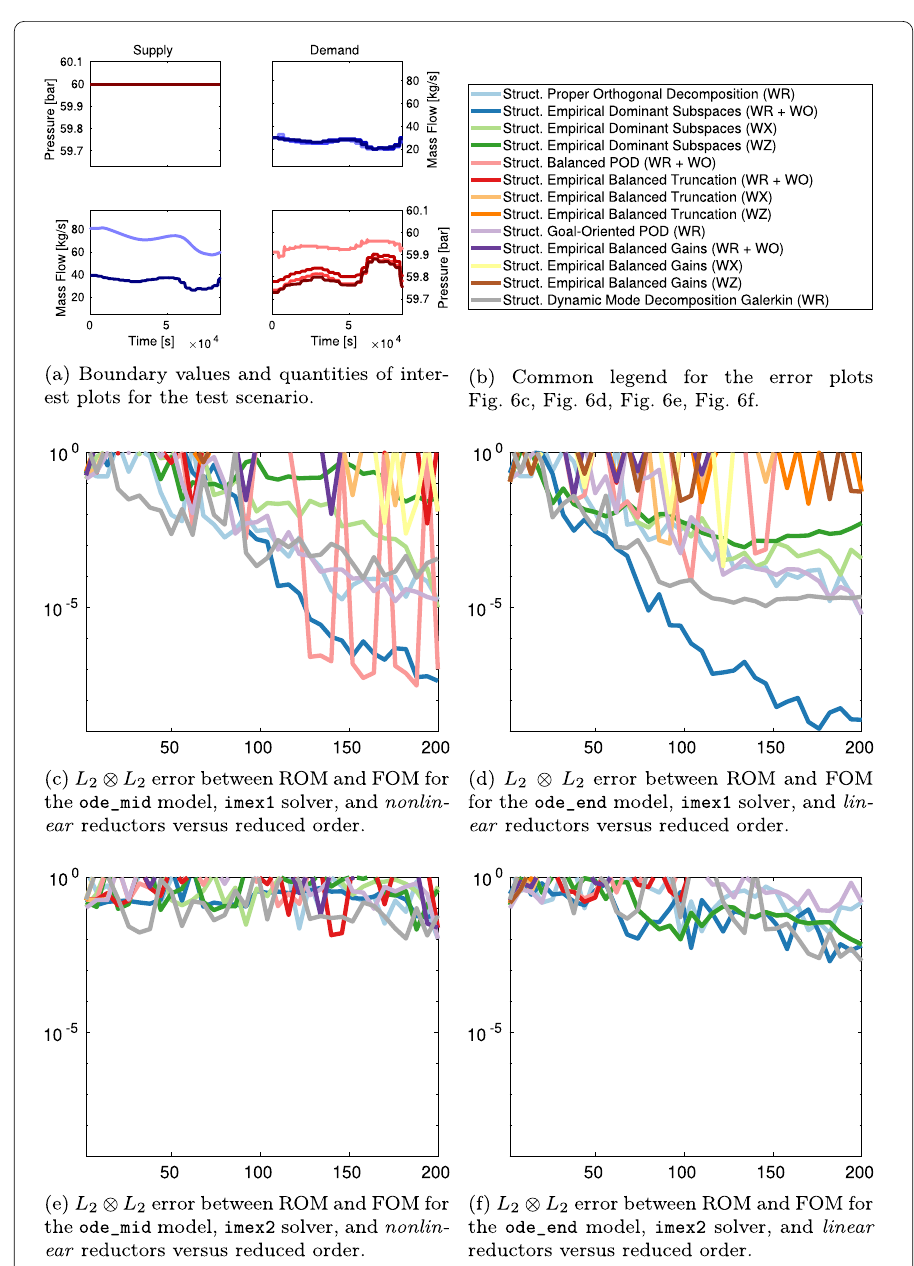
Figure 6 Visualization of the test scenario, and model reduction errors of the tested ROMs for the MORGEN network from Sect. 6.3